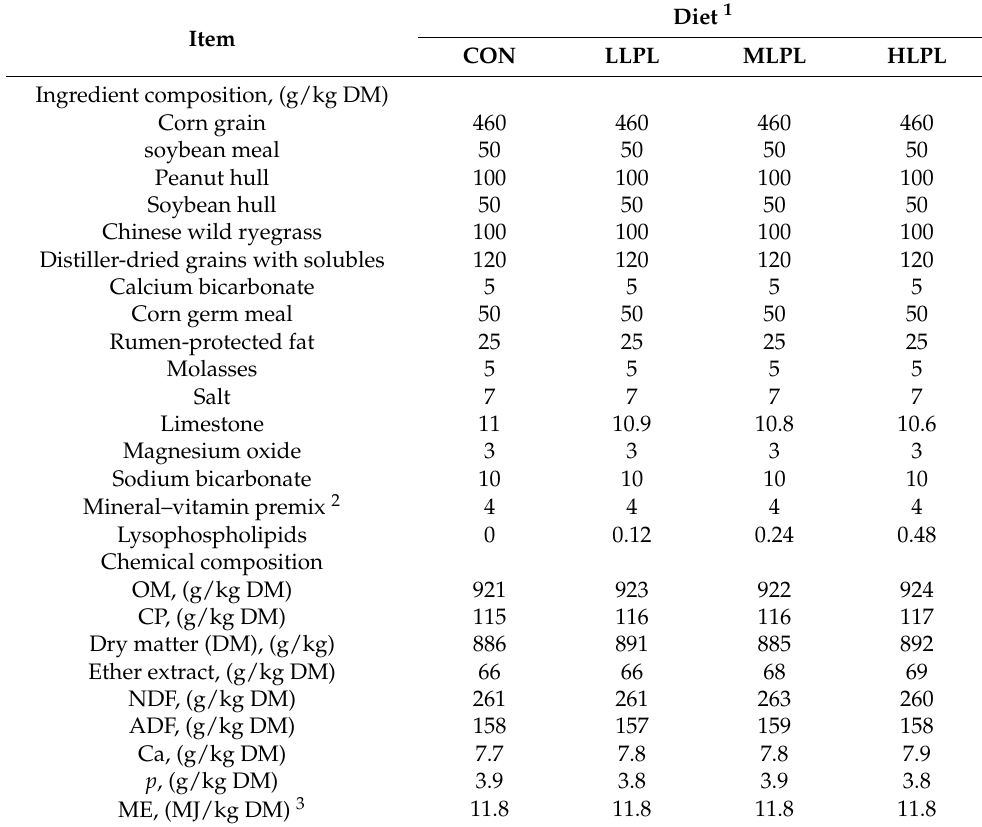
Table 1. Ingredients and nutrient compositions of the dietary treatments. Diet 1 Item CON LLPL MLPL HLPL Ingredient composition, (g/kg DM) Corn grain 460 soybean